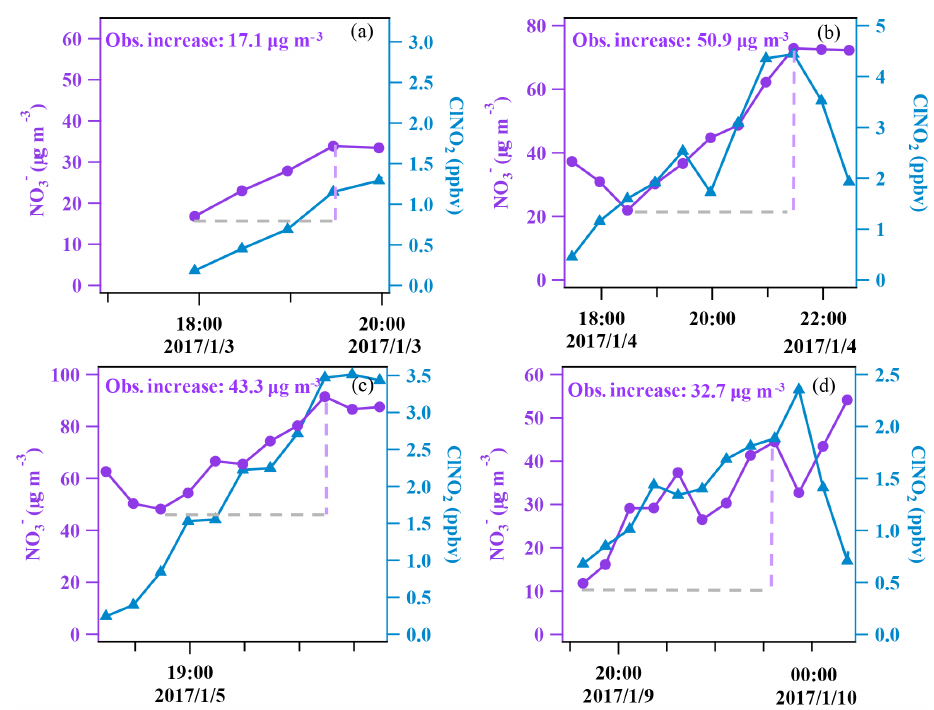
Figure 4. The covariance of aerosol nitrate and ClNO 2 in the early nighttime (at a 30min time resolution) for four